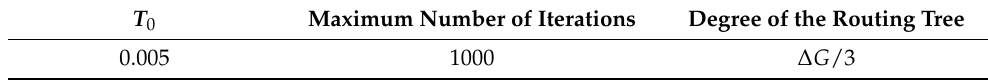
Table 2. The tag recognition effect at 50